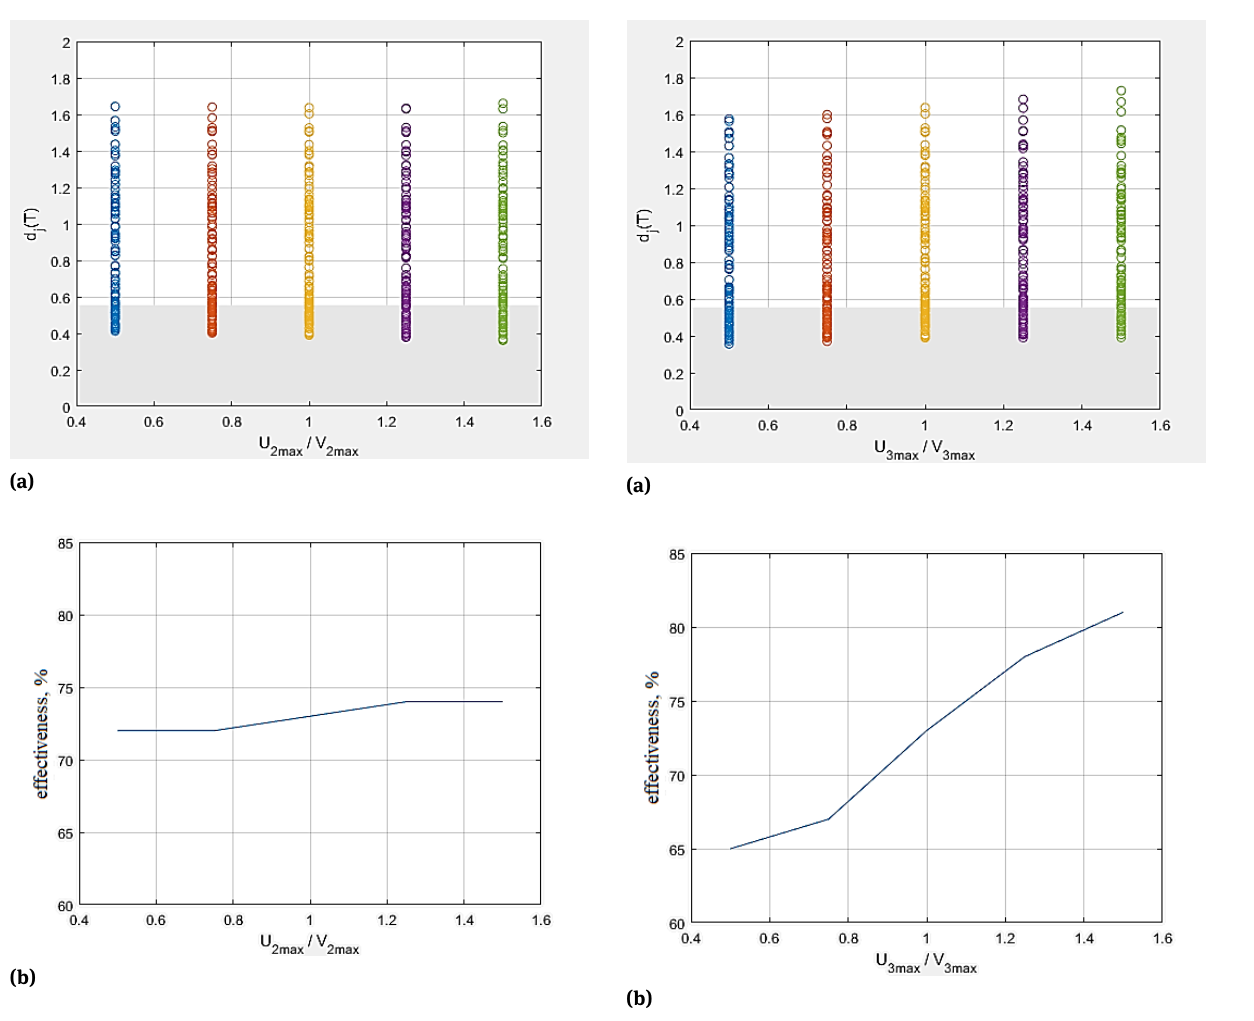
Figure 4: Influence of the attacked UAV’s “agility” on the positional advantage in comparison with the